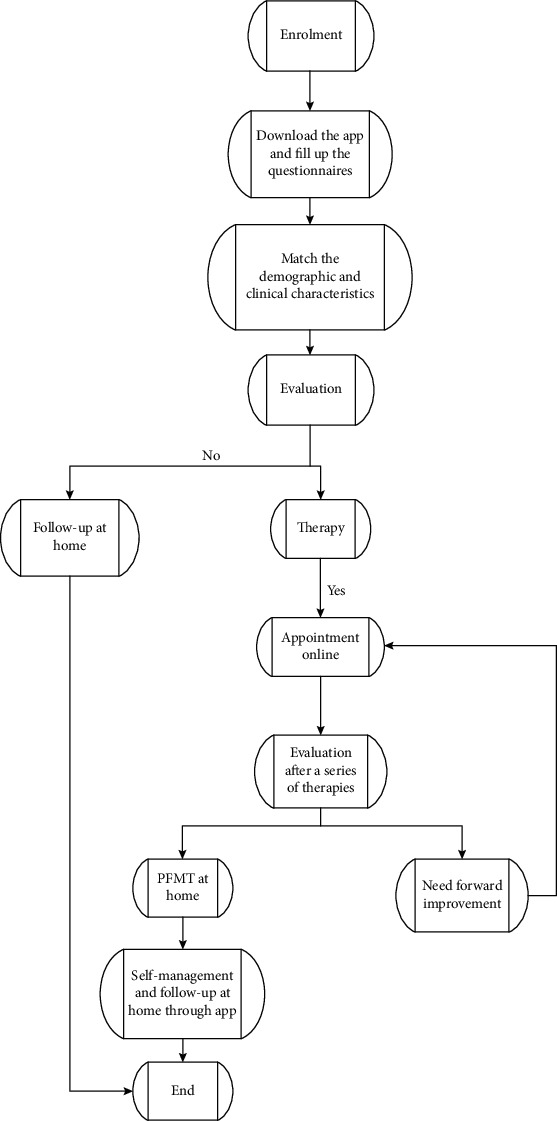
All recruited postpartum women will be introduced to download the mobile app, then they will be asked to fill in their related personal information and a series of questionnaires. The clinical evaluation will be administrated to give the results on whether the patient will be followed up at home or continue to do more therapy and improvement.